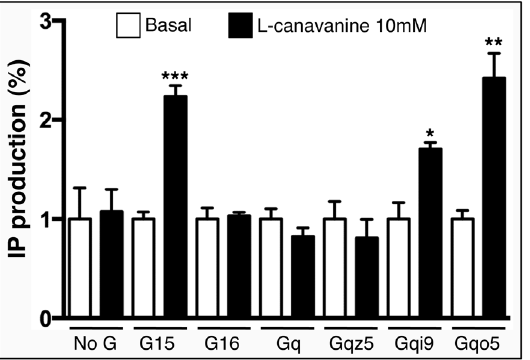
Figure 2. The GPCR DmX has the best coupling with G a o protein subtype in HEK transfected cells. L-canavanine induced- inositol phosphate (IP) production was measured from HEK cells co- expressing the DmX receptor and the indicated G a protein. As a control, we used HEK cells transfected with DmXR expression vector alone (called ‘No G’). Basal and 10 mM L-canavanine were used for all stimulations, indicated by white and black bars, respectively. IP stimulation was calculated relatively to IP production in basal conditions. HEK cells co-expressing DmXR and G a 15 , G a qi9 or G a qo5 produced IP after L-canavanine stimulation, indicating that these G a proteins can efficiently couple to DmXR, the best coupling being observed with G a qo5 . No such effect was observed with HEK cells co- expressing DmXR and G a 16 , G a q or G a qz5 . Experiments done with G a 15 could be considered as a positive control because G a 15 protein is known to couple with most GPCRs. Data are means + / 2 SEM from triplicate experiments. IP production was compared with basal activity using Unpaired Student’s t test (* p , 0.05, ** p , 0.01, *** p , 0.001). doi:10.1371/journal.pone.0063484.g002 ed. In contrast, Gr66a-Gal4/ + , UAS-RNAiG a o47A/ + , UAS- RNAiG a i65A/ + control flies and Gr66a-Gal4/ + ;UAS-RNAi-